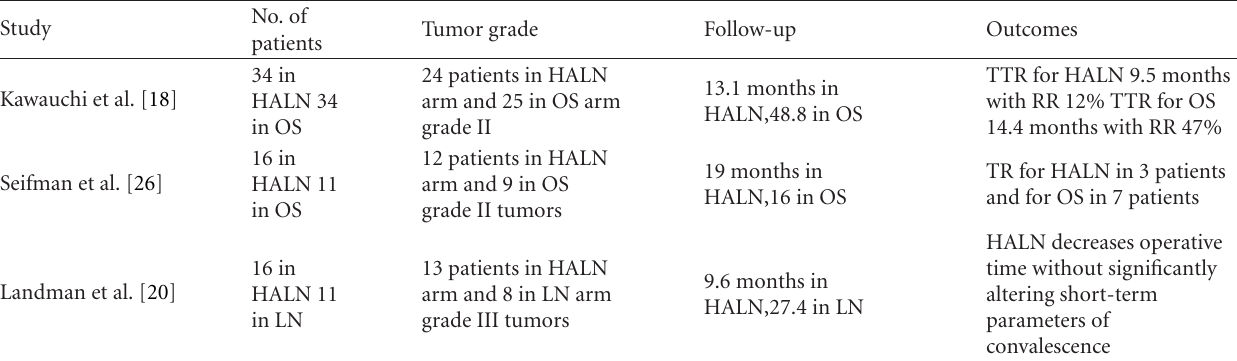
13.1 months in HALN,48.8 in OS 19 months in HALN,16 in OS 9.6 months in HALN,27.4 in LN